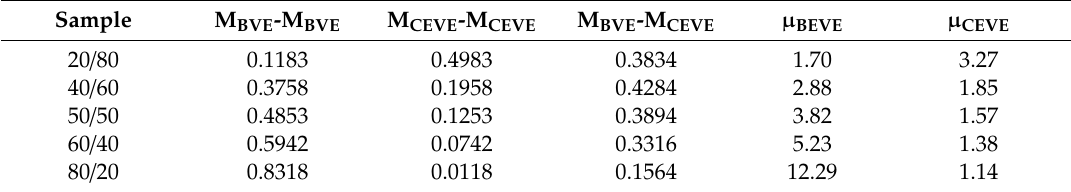
Table 3. Dyad monomer sequence distributions and mean sequence length of the statistical